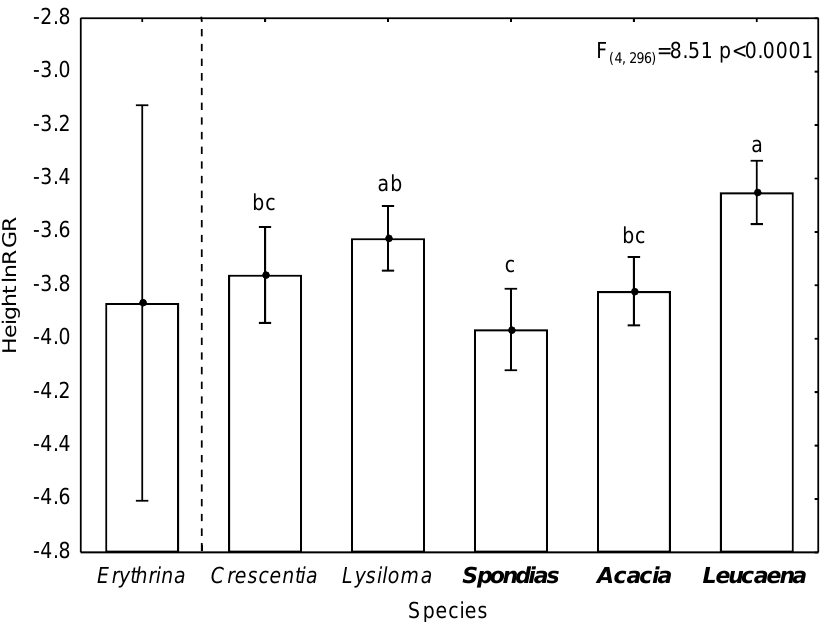
Figure 3. Forty months’ height lnRGR of six tree species growing in fenced plots at Quilamula, Morelos, Mexico. Height lnRGR for Erythrina americana is shown but this species was removed from RGR analysis due to low survival. Different letters show significant differences evaluated with Tukey test. Genera of fast-growing species are shown in bold.